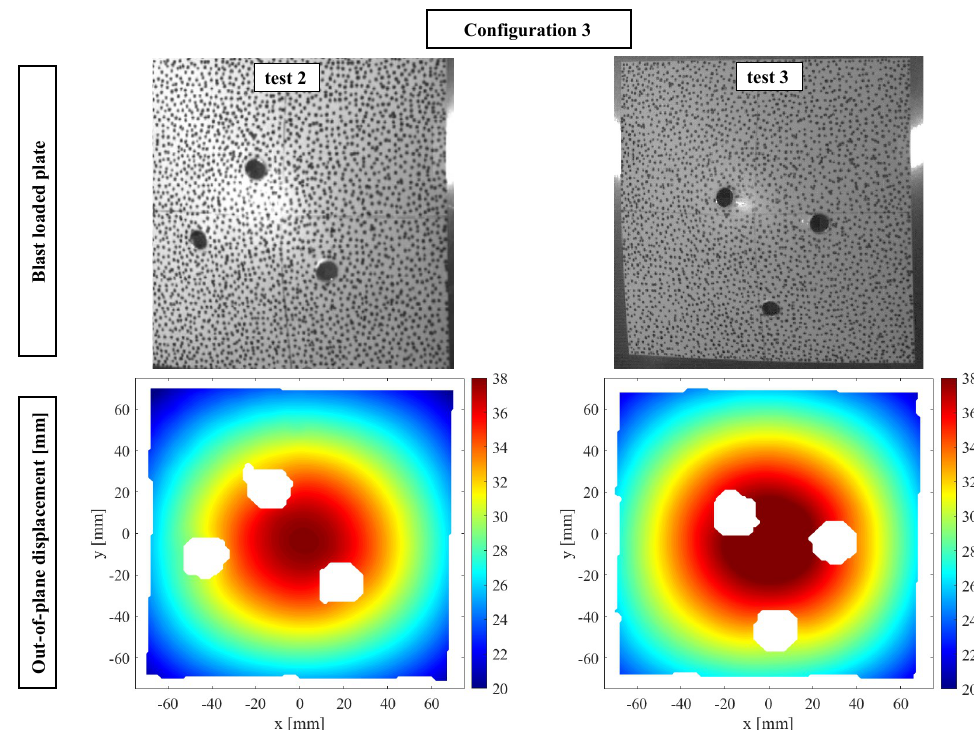
Figure 18. Plane view of permanent deformation of blast-loaded aluminum plates previously perfo- rated using three 7.62 mm FSPs (tests 2 and 3 of configuration 3). The figure illustrates the full-field displacement of the plates’